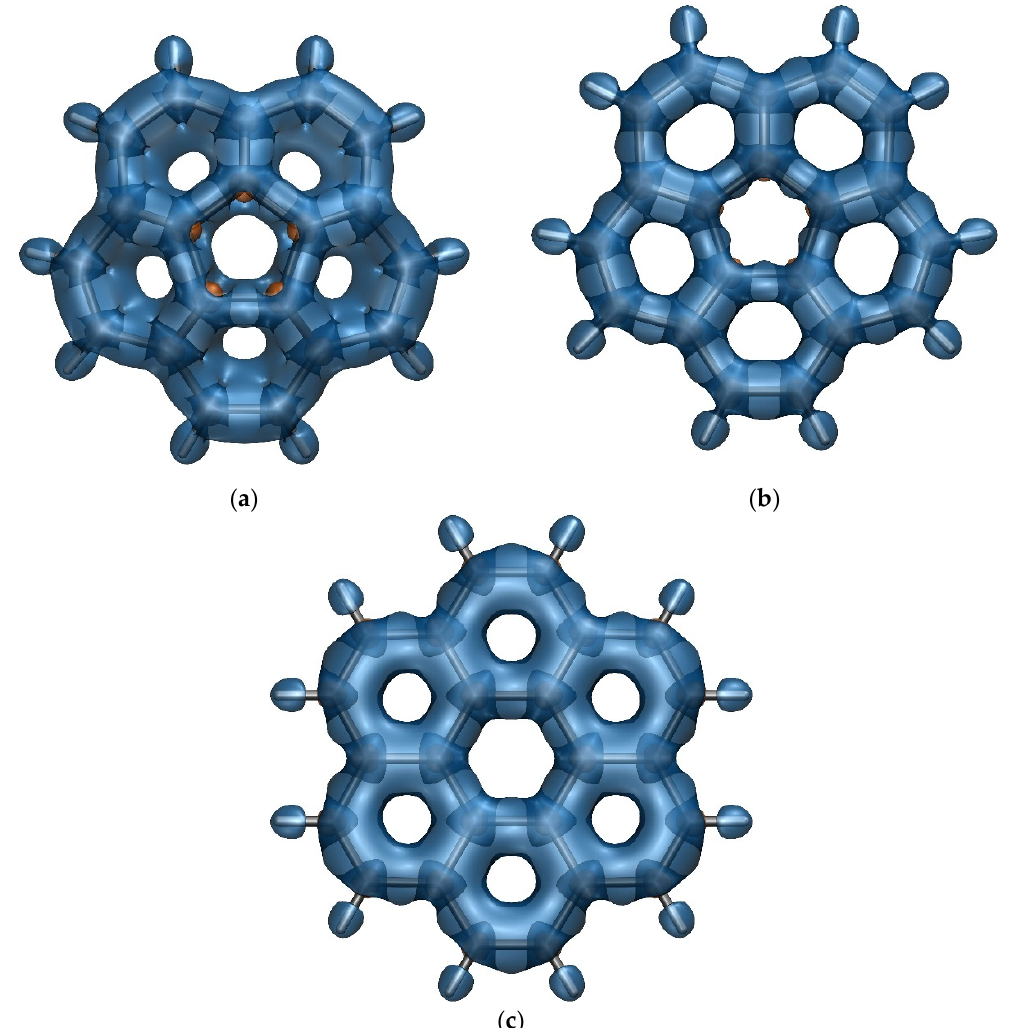
Figure 3. Top views of the isotropic shielding isosurfaces at σ iso ( r ) = ± 16 ppm for C 5v corannulene ( a ), D 5h corannulene ( b ) and D 6h coronene ( c ) (positive isovalue in blue).